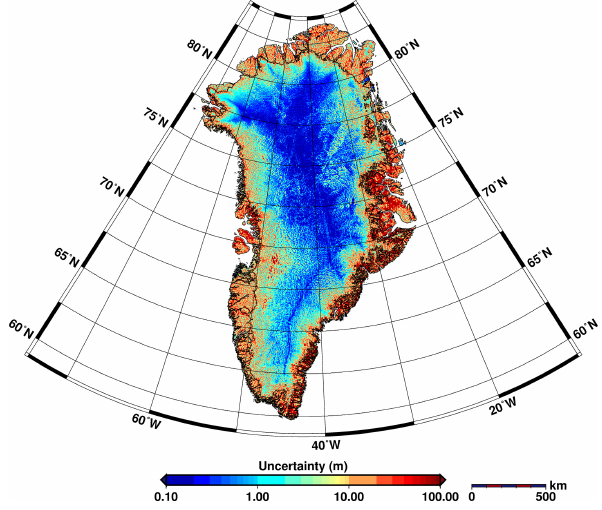
Figure A2. Uncertainty map of the new Greenland DEM calculated using a multiple regression approach based on DEM–ICESat differ-